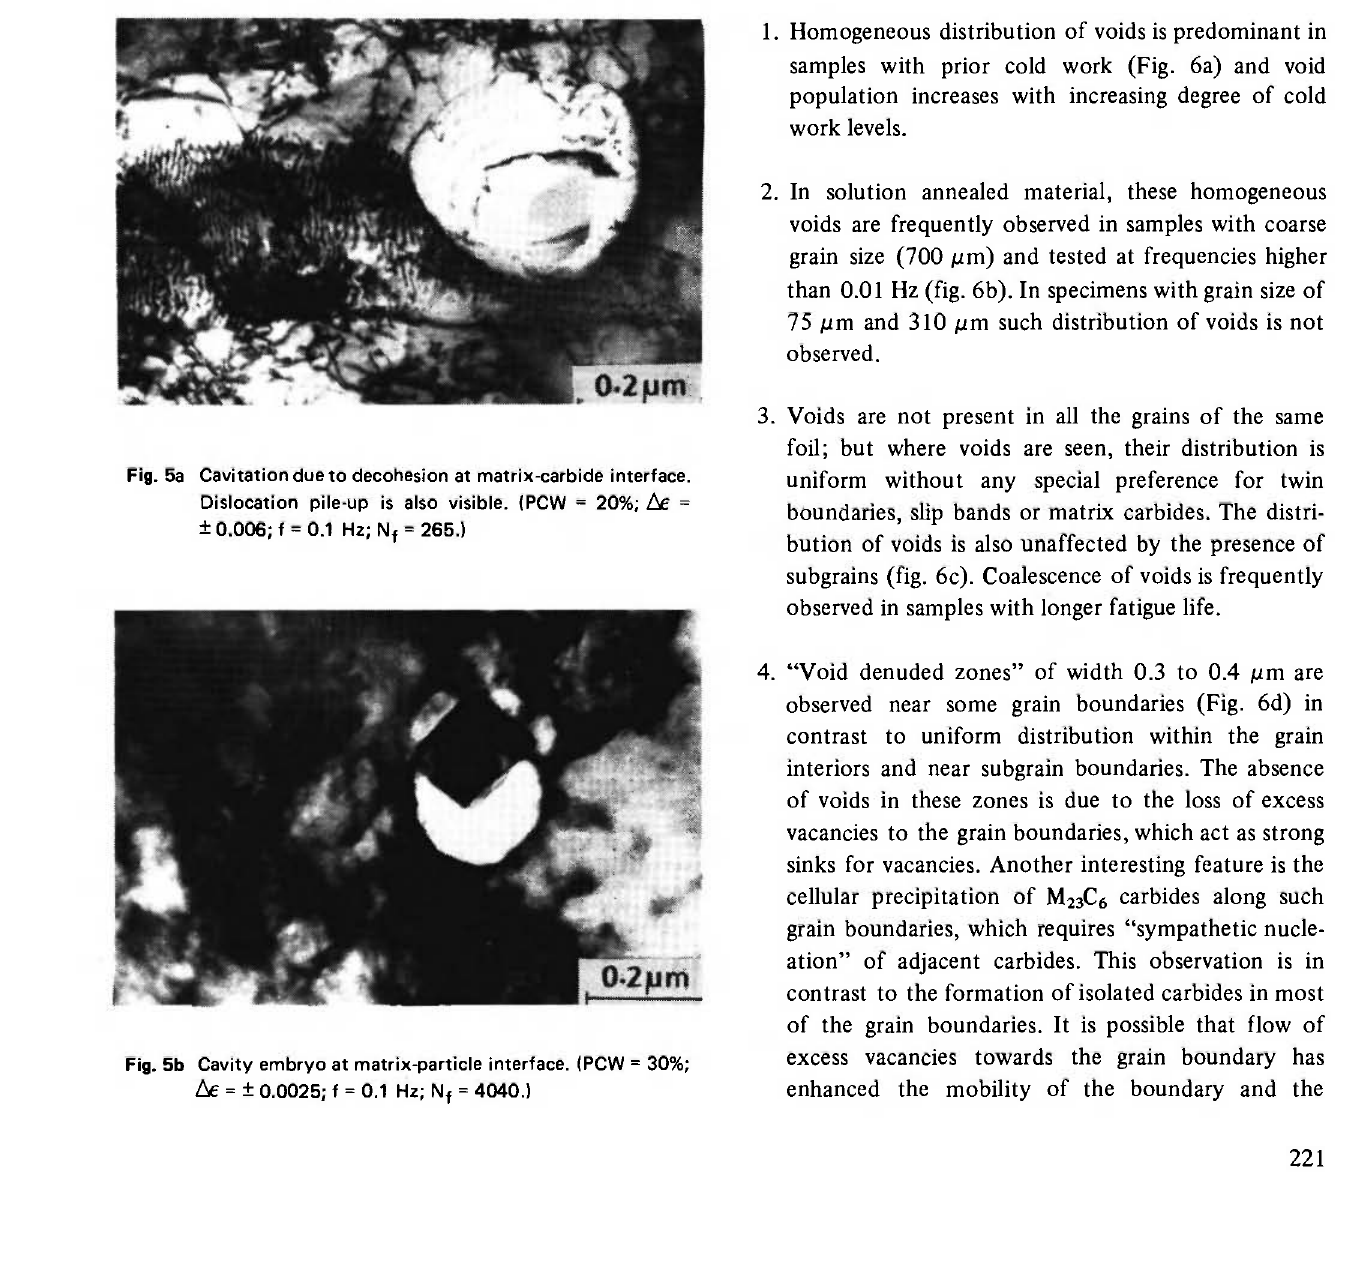
Fig. 5a Cavitation due to decohesion at matrix-carbide interface. Dislocation pile-up is also visible. (PCW = 20%; Δε = ± 0.006; f = 0.1 Hz; N f = 265.)